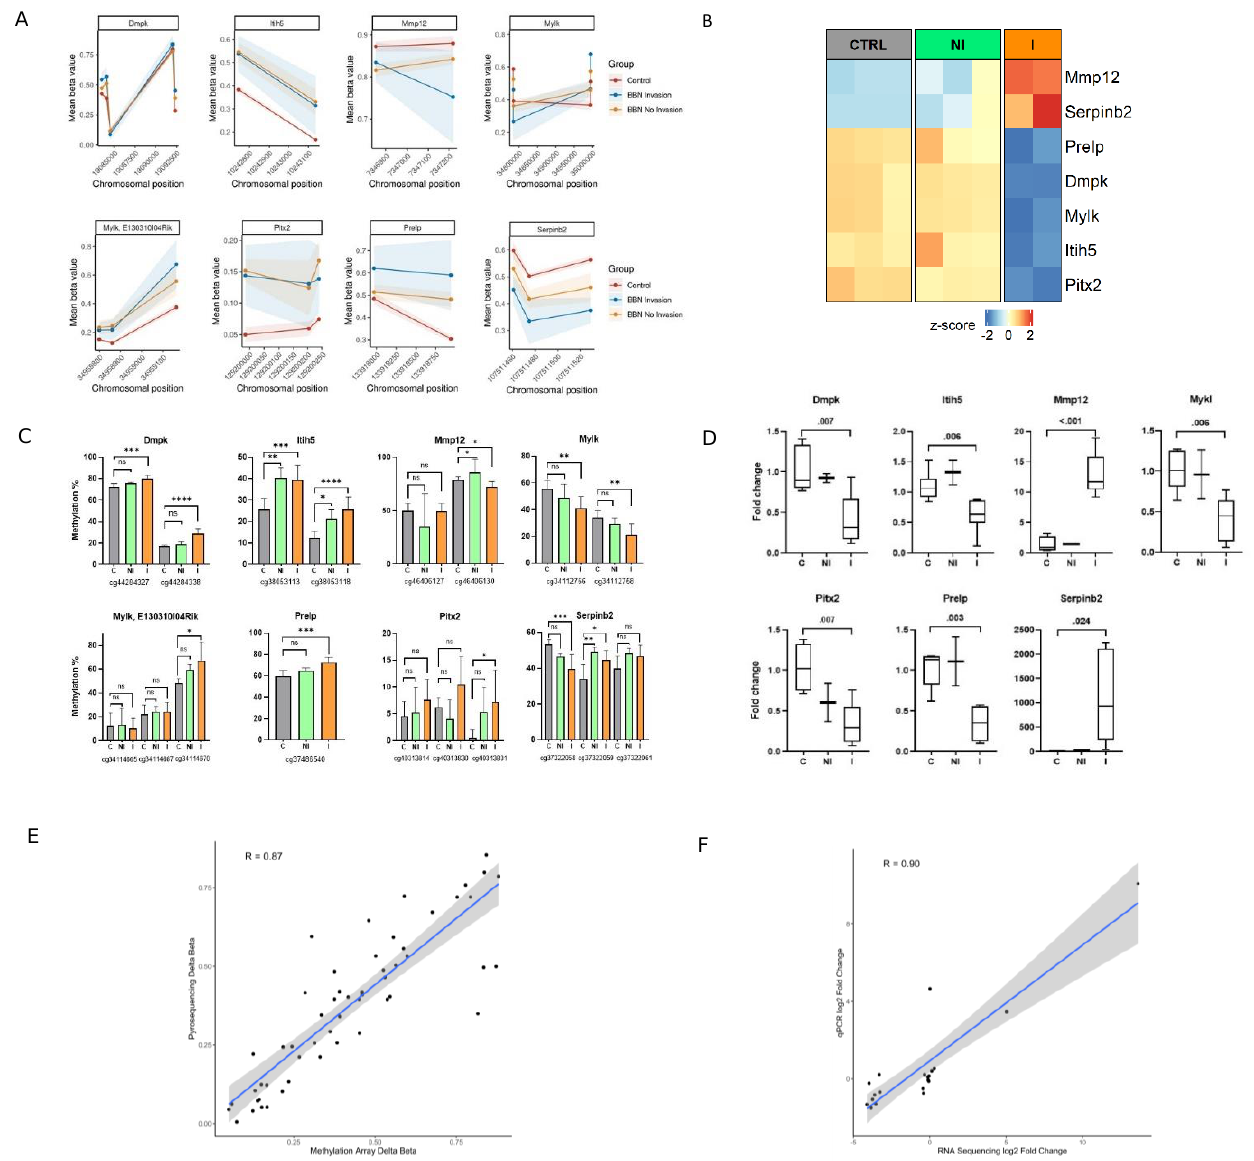
Figure 5. Validation of the changes in expression and methylation at selected gene targets. Com- parison of DNA methylation mean beta value measured by Methylation BeadChip Array ( A ) and RNA-seq expression ( B ) patterns (scaled normalized counts) of particular gene targets in BBN-treated mice with regard to their controls. ( C ) DNA methylation levels of the CpG sites (indicated below x axis) showing mean methylation in validation samples. The number of mice in the control group was 8, three in the non-invasive group and nine in the invasive BC group. Statistical analysis was performed using Kruskal–Wallis ANOVA with multiple comparisons. ( D ) Validation of gene expres- sion was done on five control mice, two non-invasive samples and six invasive tumors. Values were normalized to Actb and presented as a fold change. Statistical analysis was performed using unpaired T-test between C and I. Pearson correlation of ( E ) methylation levels between pyrosequencing and Infinium™ Mouse Methylation BeadChip, and ( F ) gene expression amongst qPCR and RNA-seq. Dots indicate individual samples. C, control; NI, non-invasion; I, invasion. * p < 0.05; ** p < 0.01; *** p < 0.001; **** p < 0.0001; ns, not